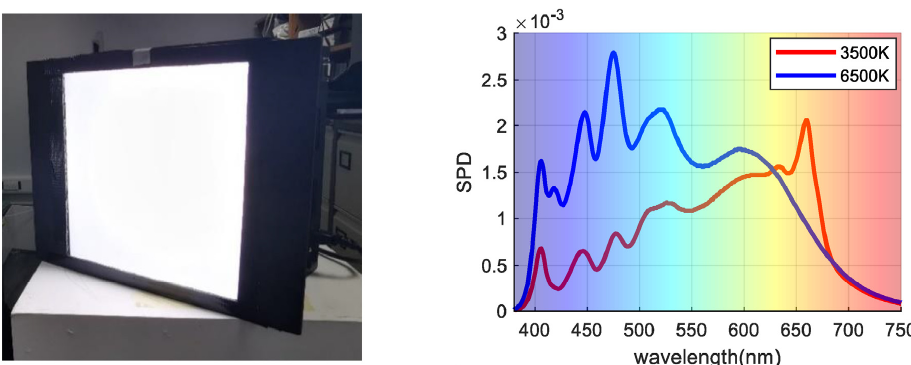
Figure 2. ( Left ) LED Cube; ( Right ) Two SPD curves under 3500 K and 6500 K illumination conditions. The parameter settings for the camera were fixed during the image capture, with the aperture size set to f5.6, the shutter speed at 1/8 s, and the ISO speed set to 640. Canon EOS Utility software was used to control the camera for the image capture. The original raw responses were recorded by the camera and used to predict spectral reflectance. The dark current noise was recorded with the camera lens cap closed and was subsequently subtracted from the captured digital